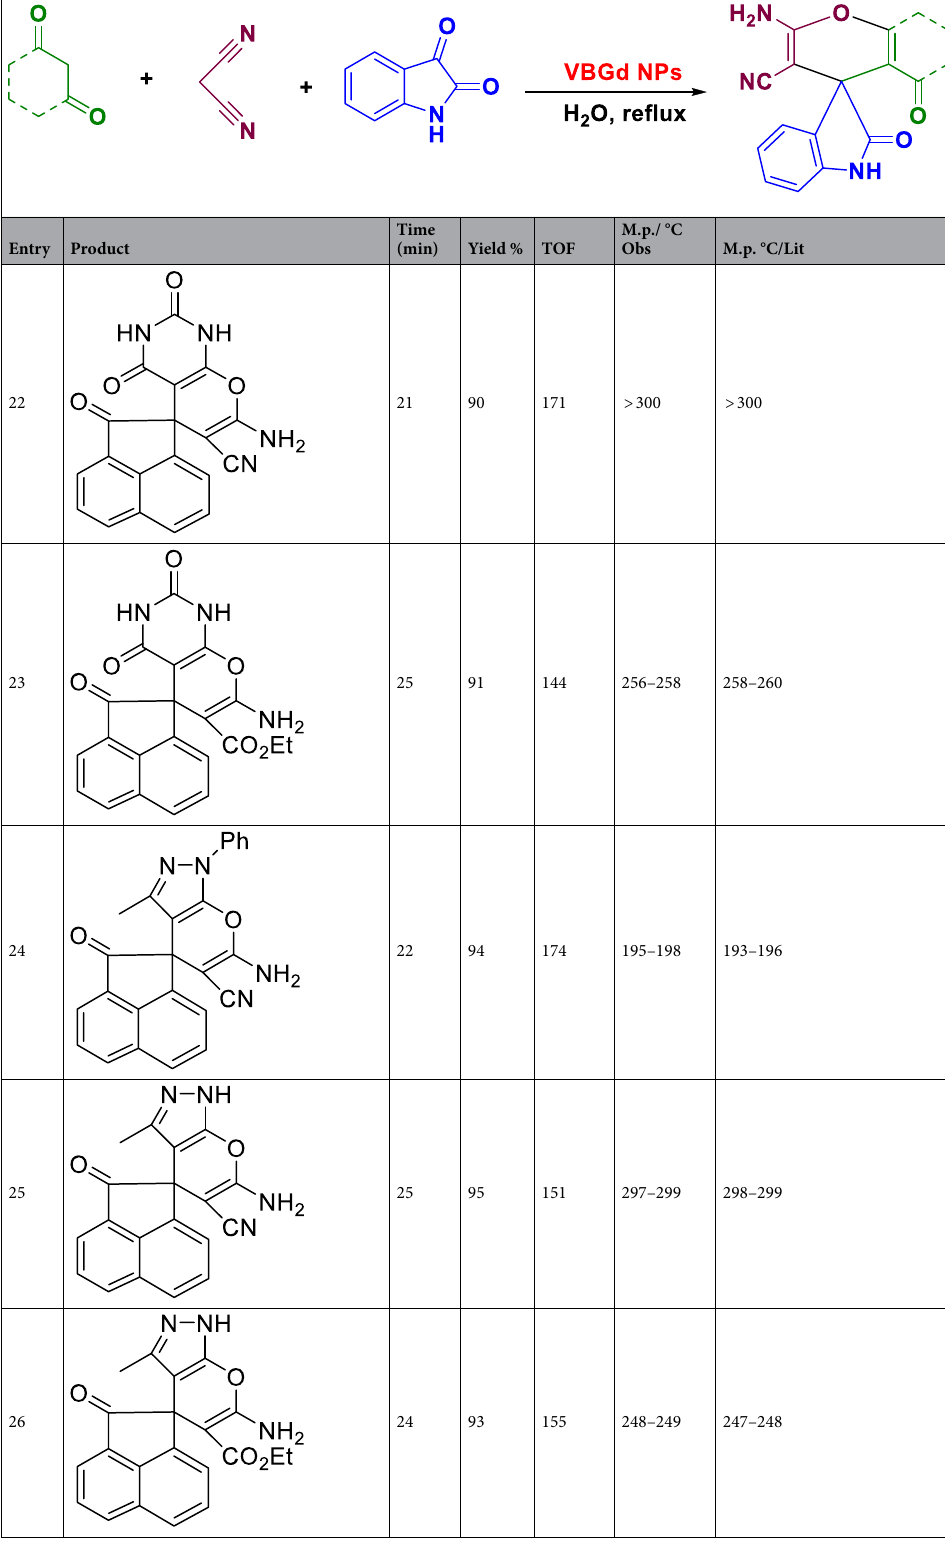
Table 3. Synthesis of spiro-2-amino-4H-pryans 37